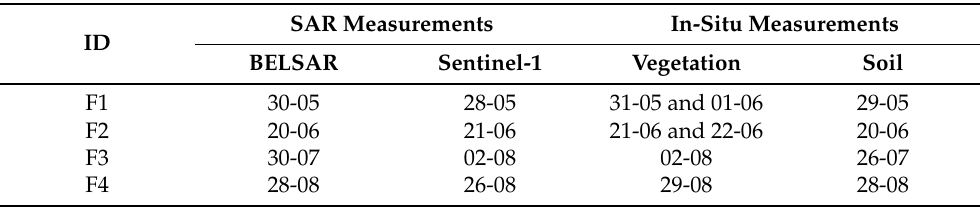
Table 1. Acquisition dates (day-month format) of the L- and C-band synthetic aperture radar (SAR) images from BELSAR and Sentinel-1, respectively, and of the corresponding in-situ measurements of vegetation and soil variables. SAR Measurements In-Situ Measurements ID BELSAR